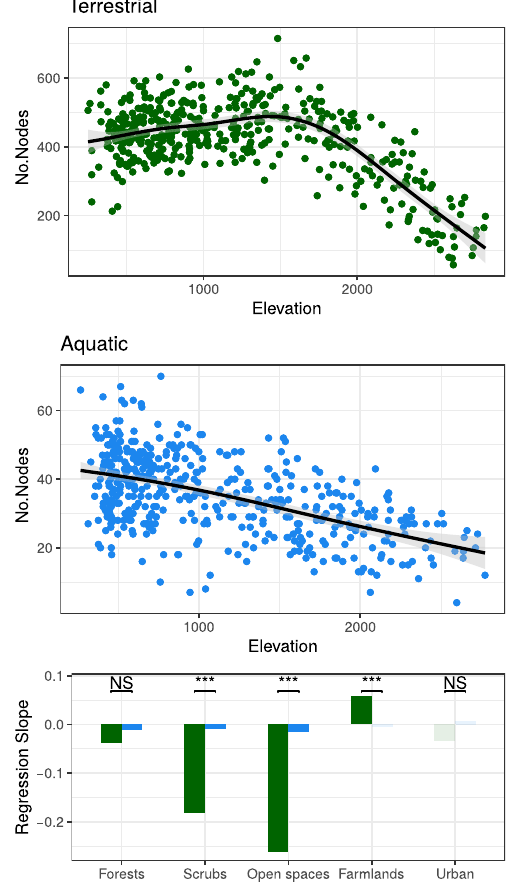
Fig.4|Numberofnodes(leftpanel)andconnectance(rightpanel)ofterrestrial (green) and aquatic (blue) food webs along elevation. In the scatter plots, black lines and corresponding shadesare the fi tted regressionand 95% CI of generalised additive models. The bottom barplots present the slope estimates from linear models testing the effects of elevation on the focal food-web property with